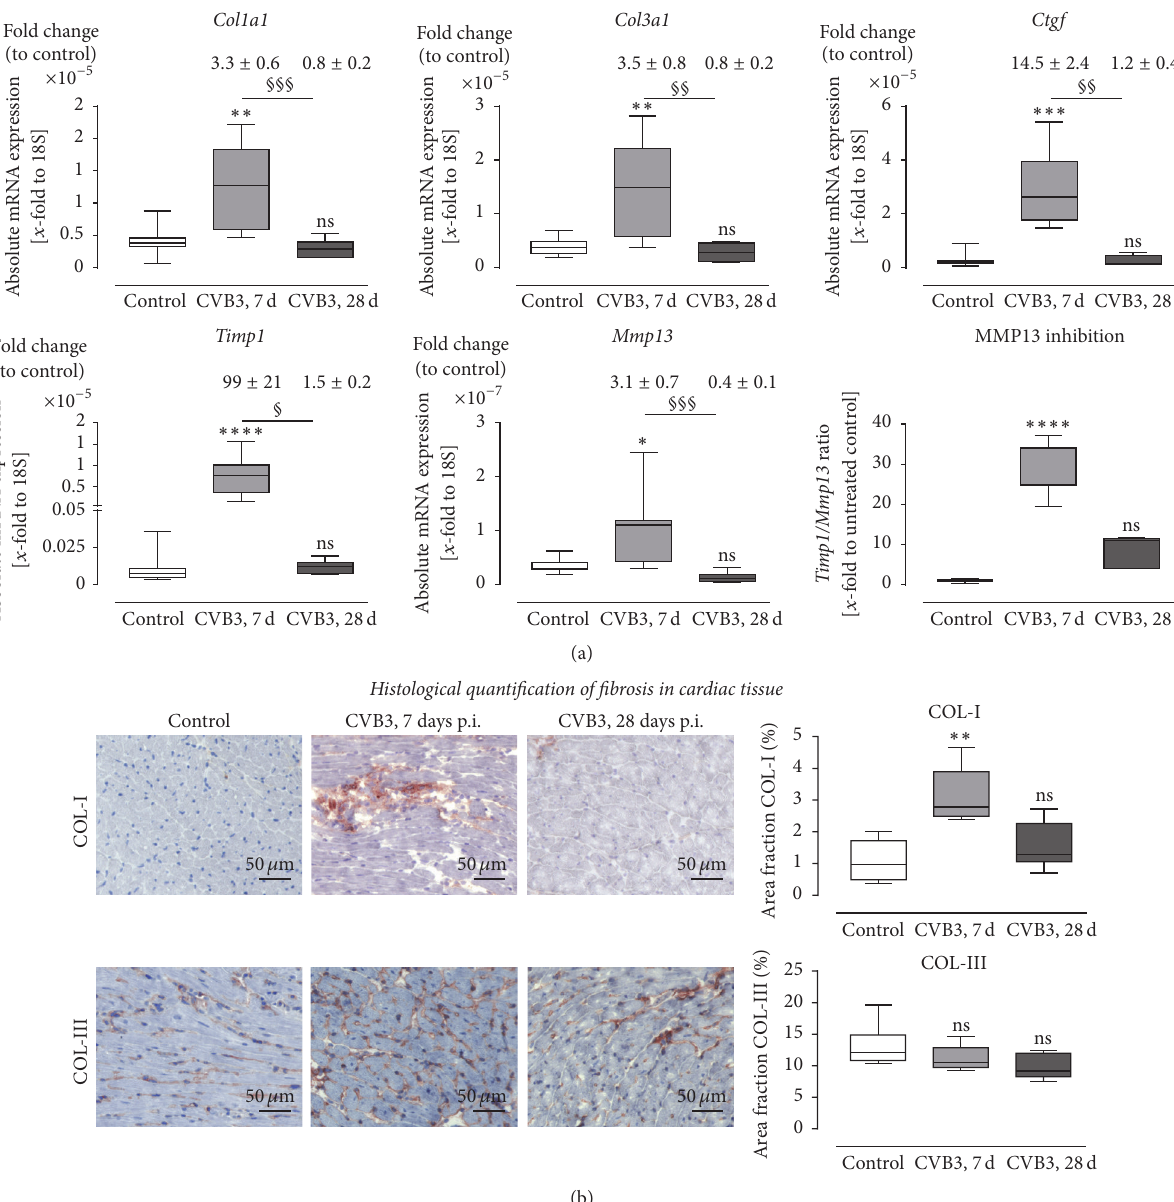
Figure 6: Expression analysis of remodeling processes in cardiac tissue of CVB3-infected C57BL/6J mice 7 and 28 days after infection. (a) Geneexpressionanalysisincardiactissueofhealthy(whitebar)andCVB3-infectedC57BL/6Jmice7daysp.i.(lightgreybar)aswellas28days p.i. (dark-grey bar) was determined using TaqMan analysis. The mRNA expression of profibrotic genes Col1a1 , Col3a1, and Ctgf was increased in mice 7 days after CVB3 infection and dropped down to normal expression levels 28 days after infection. Furthermore, expression of genes involved in the regulation of ECM degradation was increased within 7 days after infection. Timp1 , the endogenous inhibitors for MMPs, as well as the collagenase Mmp13 was significantly upregulated in cardiac tissue 7 days after infection. Since the Timp1 expression raised more than the Mmp13 expression the ratio Timp1 / Mmp13 revealed an increased Mmp13 inhibition. Data are presented as absolute mRNA expression ( 𝑥 -fold to the house keeping gene 18S) in box plots as well as in fold change to control animals as mean ± SEM above the corresponding bar using the formula 2 −ΔΔ Ct . (b) Detailed histological stainings were performed to quantify cardiac remodeling and plotted as area fraction of healthy (white bar) and infected C57BL/6J mice 7 days p.i. (light grey bar) and 28 days p.i. (dark-grey bar). Tissue sections were stained for COL-I as well as COL-III. COL-I staining of cardiac tissue yielded in a significant increase of fibrosis in CVB3-infected mice 7 days after infection compared to healthy controls. Analyses of COL-III did not show significant changes in cardiac tissue after CVB3 infection; ∗ significantly different compared to noninfected mice (control); ∗ 𝑃 < 0.05 ; ∗∗ 𝑃 < 0.01 ; ∗∗∗ 𝑃 < 0.001 ; ∗∗∗∗ 𝑃 < 0.0001 ; § significantly different compared to 7 days p.i.; § 𝑃 < 0.05 ; §§ 𝑃 < 0.01 ; §§§ 𝑃 < 0.001 ; ns not